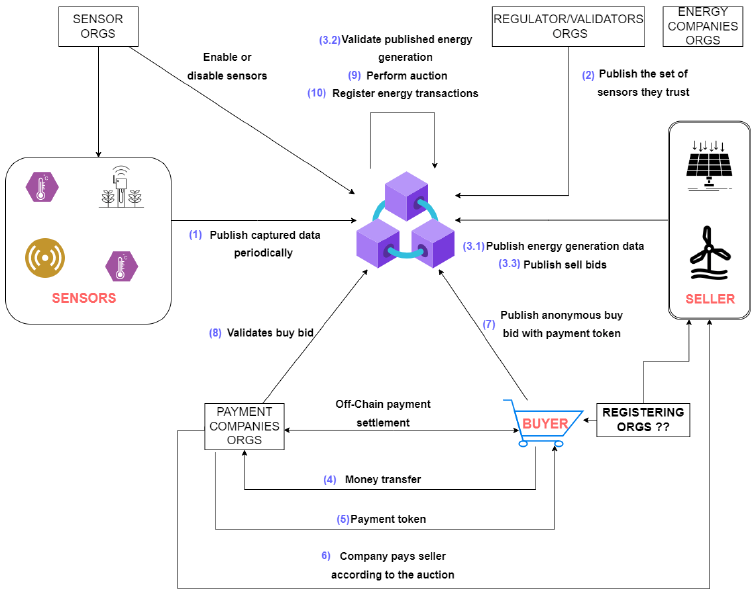
Figure 1. Model entities and their